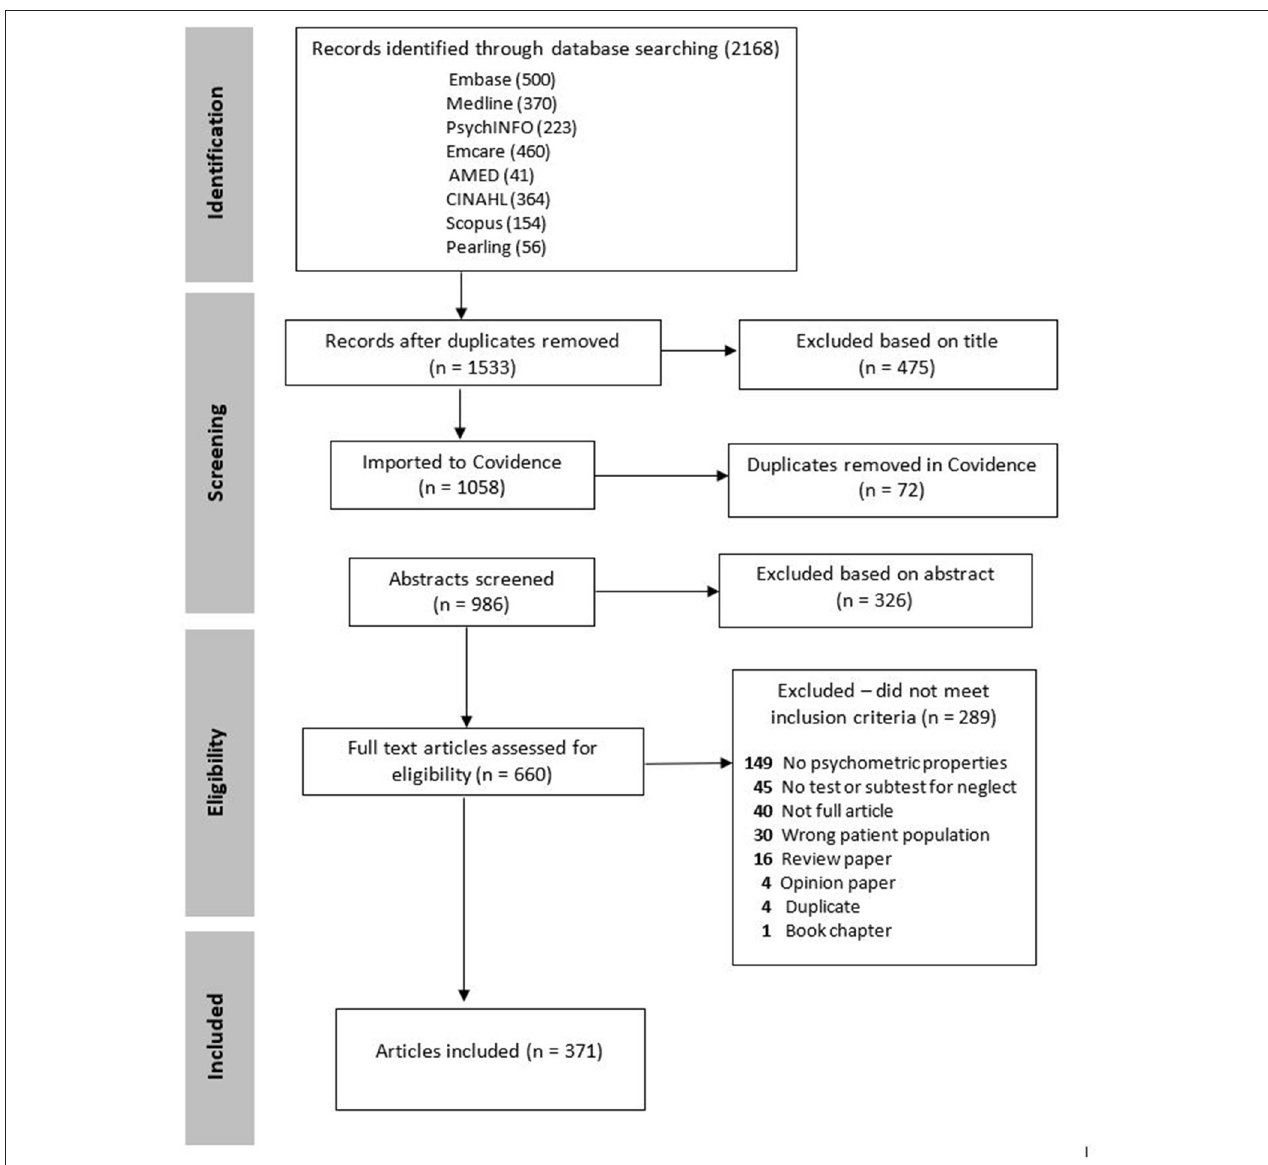
FIGURE 1 | PRISMA screening flowchart of included studies.